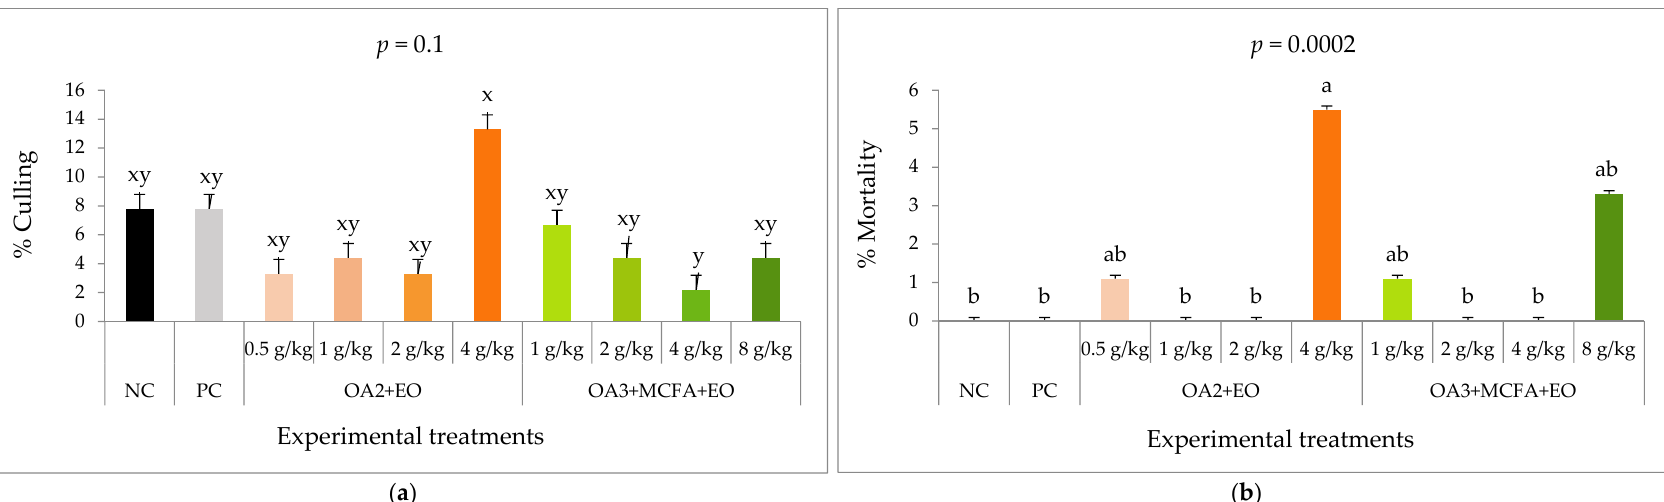
Figure 4. Culling ( a ) and mortality ( b ) calculated as a percentage from the total of chickens per treatment (90 chickens). a,b Means with different superscripts indicate significant differences ( p ≤ 0.05). x,y Means with different superscripts indicate a tendency toward significance ( p ≤ 0.1). NC: Negative control; PC: positive control; OA2: Calcium butyrate + fumaric acid; OA3: Calcium butyrate + fumaric acid + citric acid + MCFA; MCFA: Capric-caprylic acid + caproic acid + lauric acid; AC: Cinnamaldehyde, carvacrol, and thymol as major compounds.